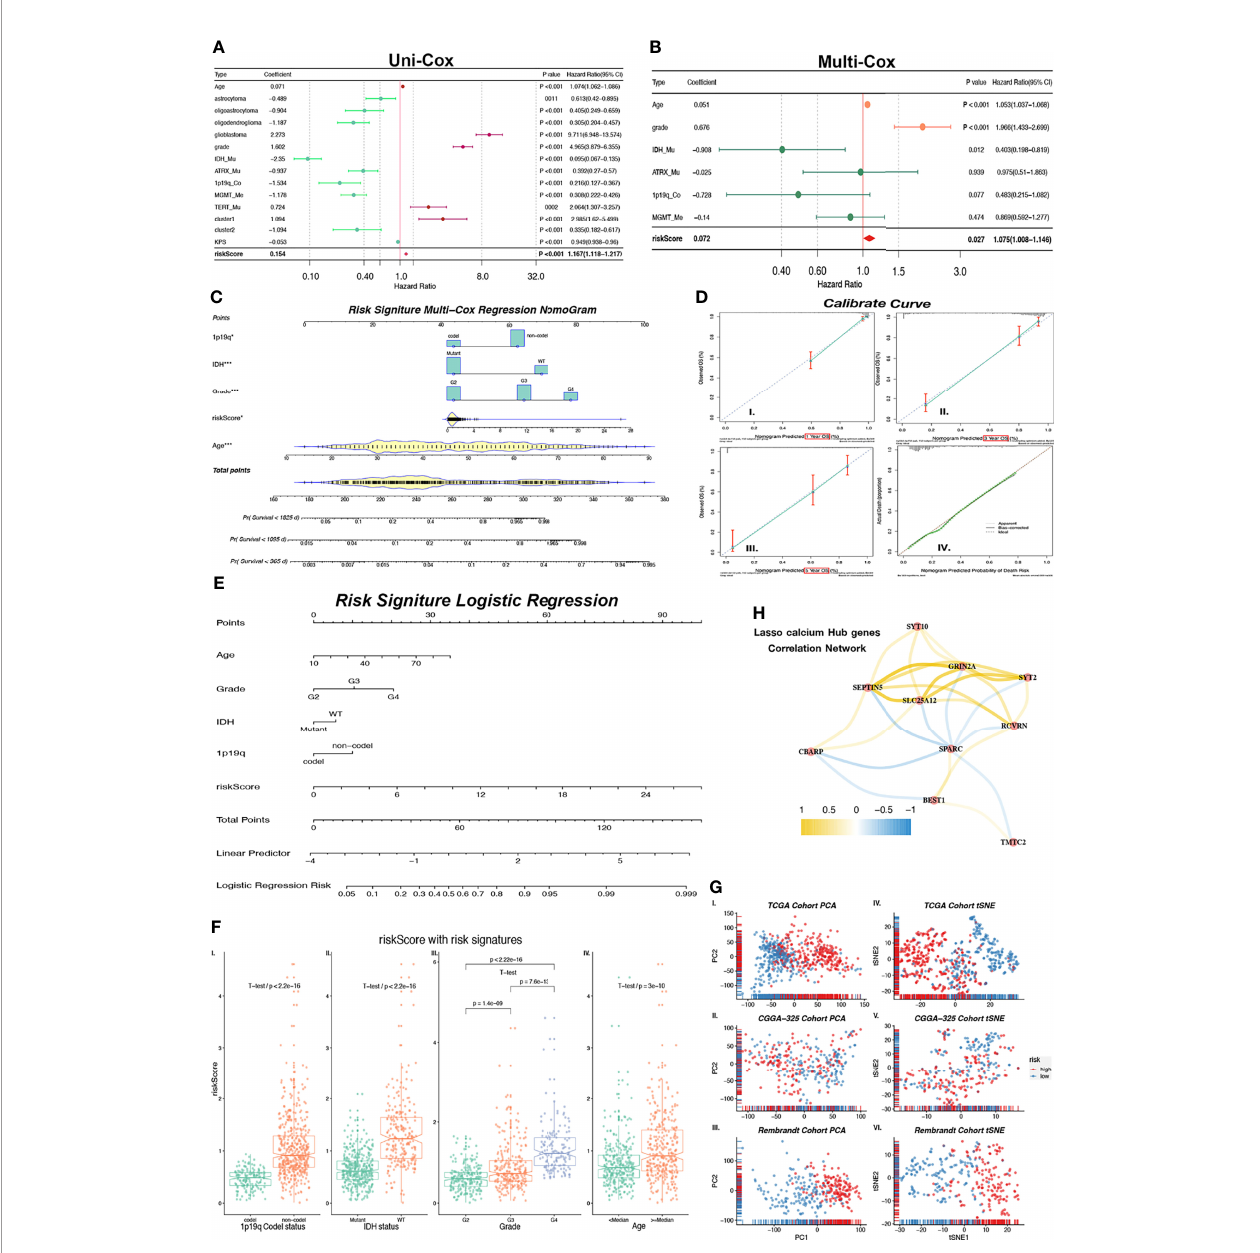
FIGURE 5 | Nomogram constructed with independent predictor of risk core, 1p19q, IHD, Grade and age. (A) Forest plot shows indicators HR values calculated by Uni-Cox regression. HR < 1 is in green color and HR > 1 is in purple color. (B) Forest plot shows P and HR values calculated by Multi-Cox regression with clinical indicators (Age, Grade, IDH, ATRX, 1p19q, MGMT) and risk score. HR < 1 is in green color and HR > 1 is in red color. Indicators with P < 0.05 are considered as glioma independent predictor. (C) Multi-Cox regression Nomogram of 1/3/5-year predicted survival with independent predictor. (D) Calibrate curves of Multi-Cox regression Nomogram (I-III.) and logistic regression Nomogram (IV.). (E) Logistic regression Nomogram of predicted risk degree with independent predictor. (H) Correlation expression network with GHGs. Positive correlation is in yellow color, and negative correlation is in blue color. (F) Risk score levels with risk signatures (1p19q, IDH, Grade, Age). (G) Unsupervised clustering (PCA: I-III. and tSNE: IV – VI.) of train (TCGA) cohort and external independent validation (CGGA-325 and Rembrandt) cohort show satis fi ed classi fi cation of glioma patients according to low/high-risk groups. *p < 0.05; ***p <